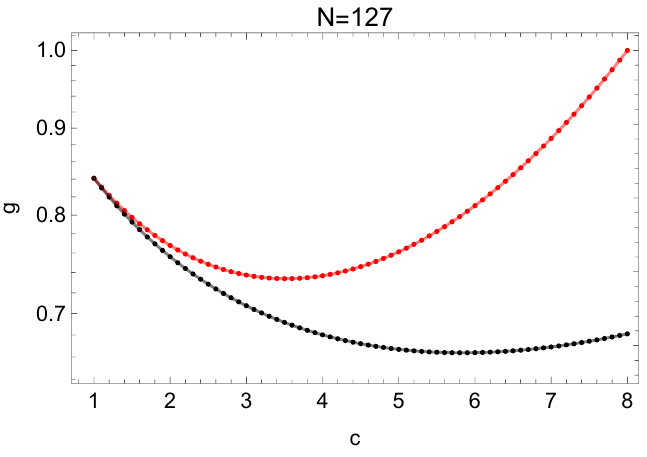
+ 1 , which is close to the maximal 6 3